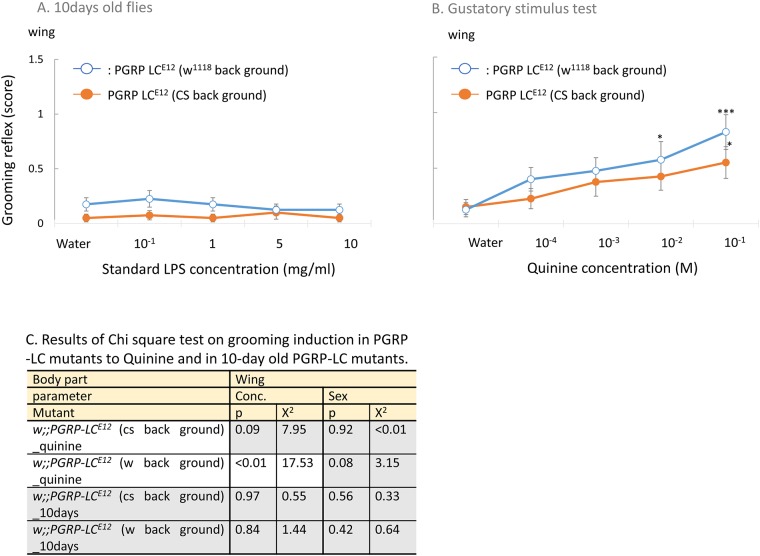
(A) Grooming behavior induced in 10-day old PGRP-LCE12 mutants in orange circle with orange line: CS background and white circle with blue line: w1118 background. (B) Grooming behavior induced by quinine in PGRP-LCE12 mutants of orange circle with orange line: CS background and white circle with blue line: w1118 background flies. A significant increase in response from that of the control (water) is indicated by asterisks: * indicates p < 0.05, ** indicates p < 0.01, and *** indicates p < 0.001 (Dunnett’s test). (C) shows the results of Chi-square test in PGRP-LC mutants to Quinine and in 10-day old PGRP-LC mutants. Mutants, which showed significant concentration-dependent behavioral increase were in white zone, and no-significance in gray zone. White zone in a table shows significant difference (p < 0.05), and grey zone indicates no-significance (p > 0.05).